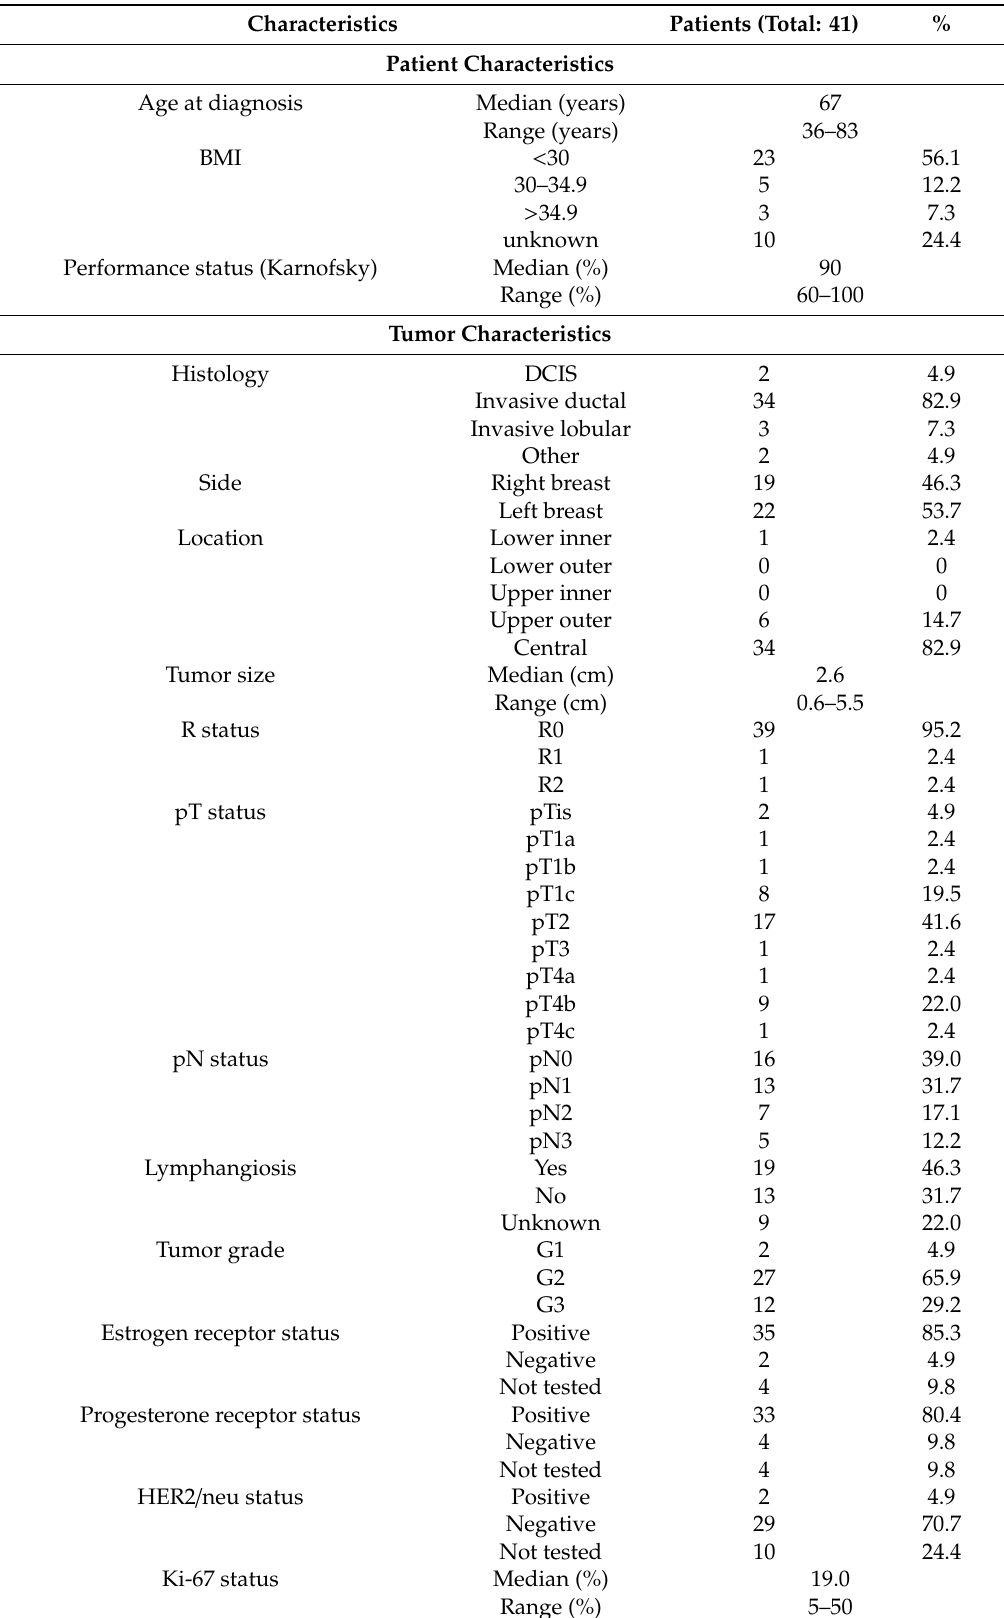
Table 1. Characteristics of patients, tumor, and